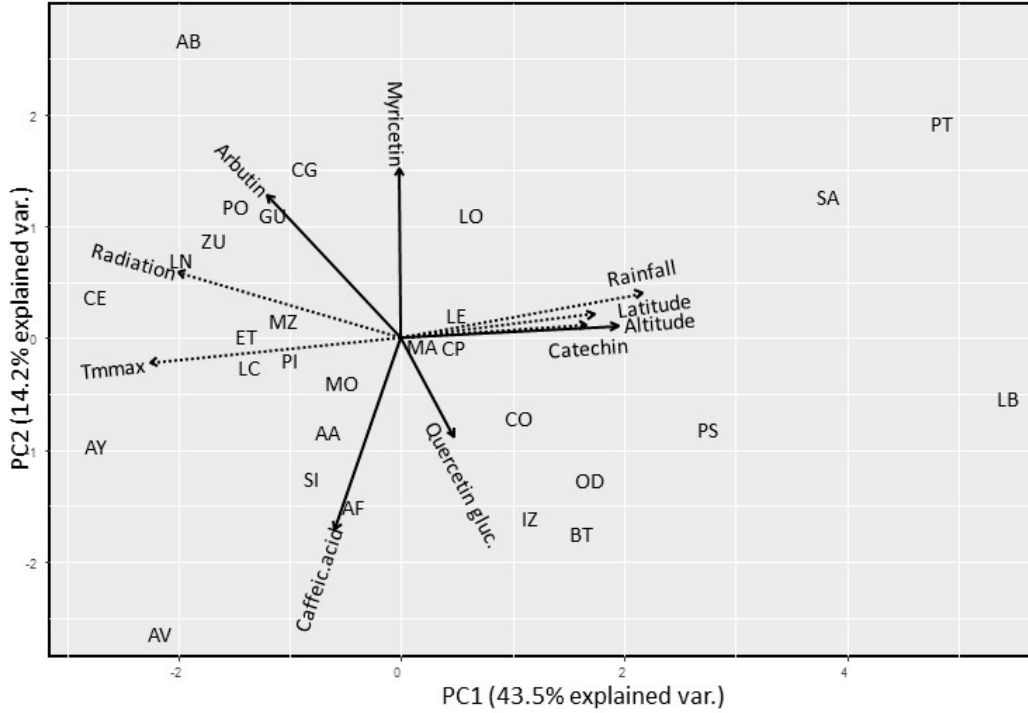
Figure 5. Principal components analysis of variation observed for mean contents (mg/g dr wt) in arbutin, caffeic acid, catechin, myricetin, and quercetin glucoside of 29 Spanish bearberry natural populations located at different latitudes and altitudes, and under different climatic conditions (annual rainfall, maximum mean temperature, and global radiation) that were sampled in autumn 2016.